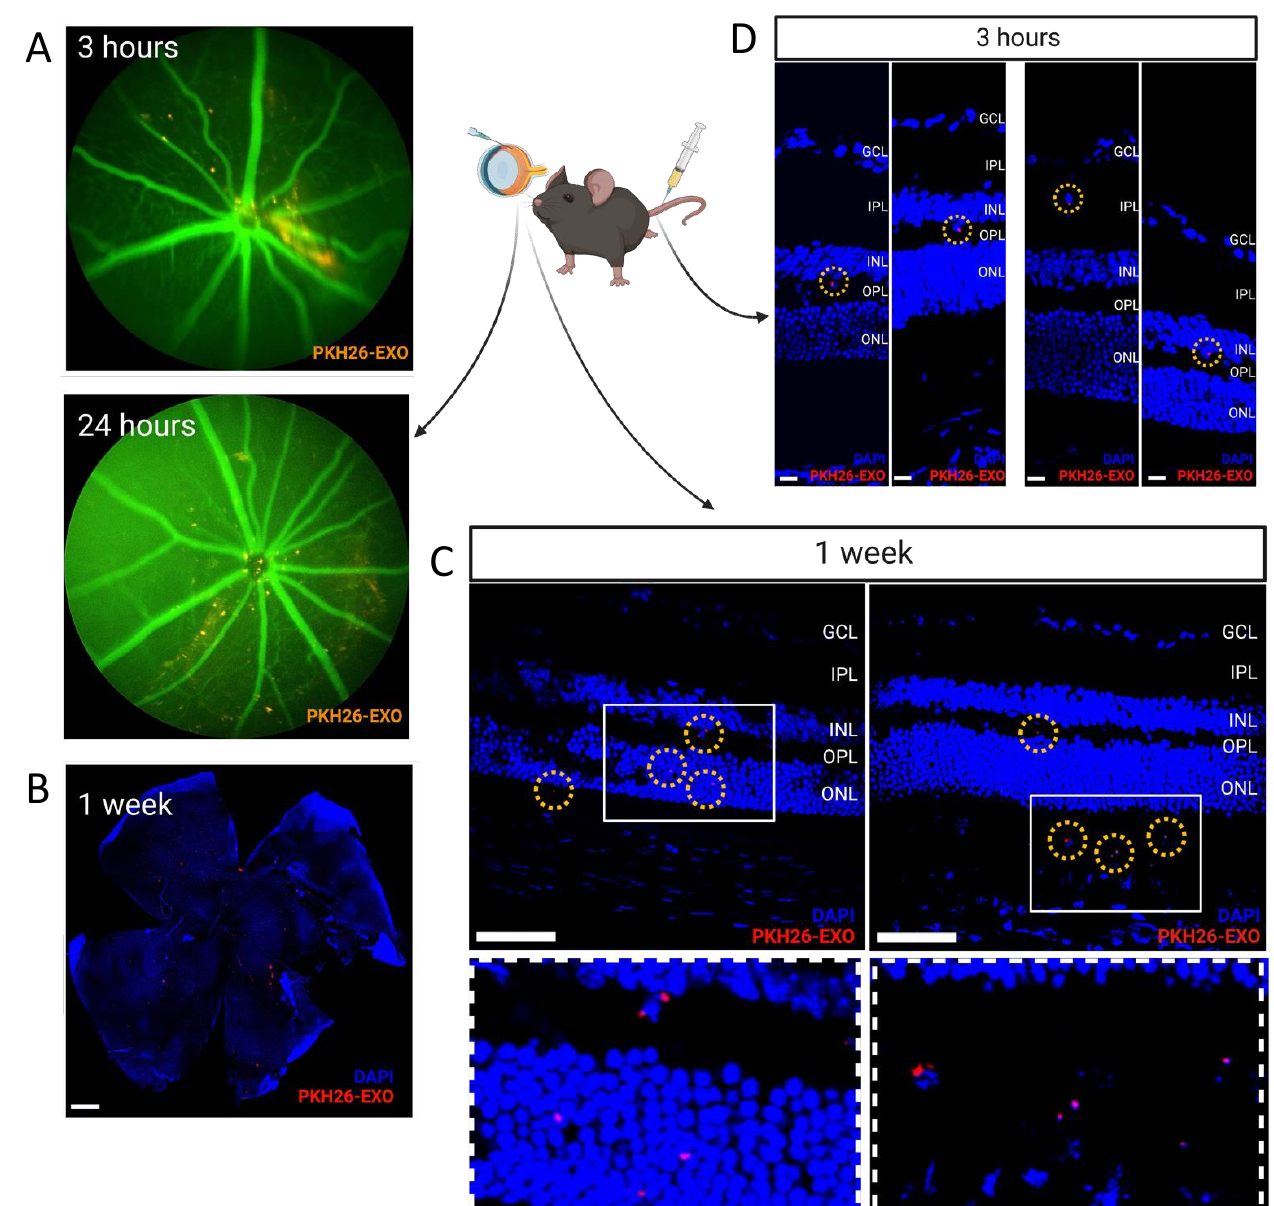
Figure 2. Retinal uptake of intravitreally delivered exosomes and BRB crossing of systemically delivered exosomes. In vivo retinal imaging microscopy performed at 3 and 24 h and retina flat- mounts obtained 1 day and 1 week after intravitreal injection of PKH-26-labeled exosomes (orange- red) show immediate retinal penetration and wide distribution of intravitreally delivered exosomes ( A , B ). Retinal sections (8 µ m) obtained 24 h after intravitreal injection of PKH-26-labeled exosomes (ret dots with yellow circles) shows that exosomes were taken up by both the inner and outer retina (Scale bar, 500 µ m) ( C ). Retinal sections (8 µ m) obtained 3 h after systemic injection of PKH-26-labeled exosomes (ret dots with yellow circles) via tail vein injection shows that exosomes were taken up by the retina, suggesting that exosomes can cross the blood-retina barrier (BRB). (Scale bar, 10 µ m) ( D ).